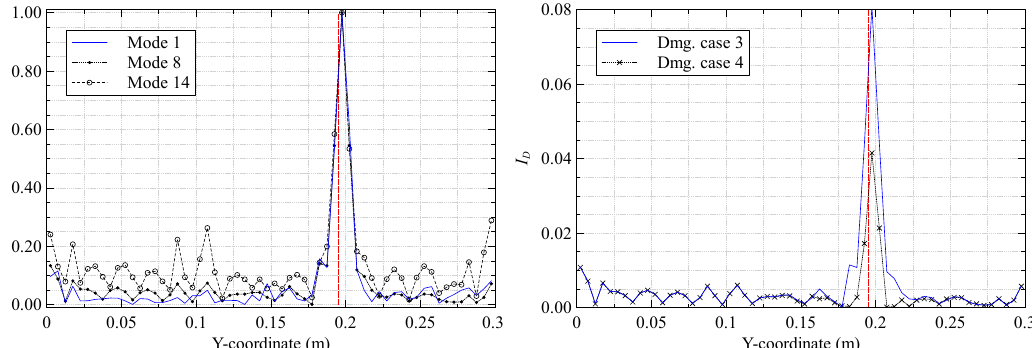
Figure 10. Damage index plots along x = 72.5 mm for ( left ) damage case 3 and ( right ) mode 8.